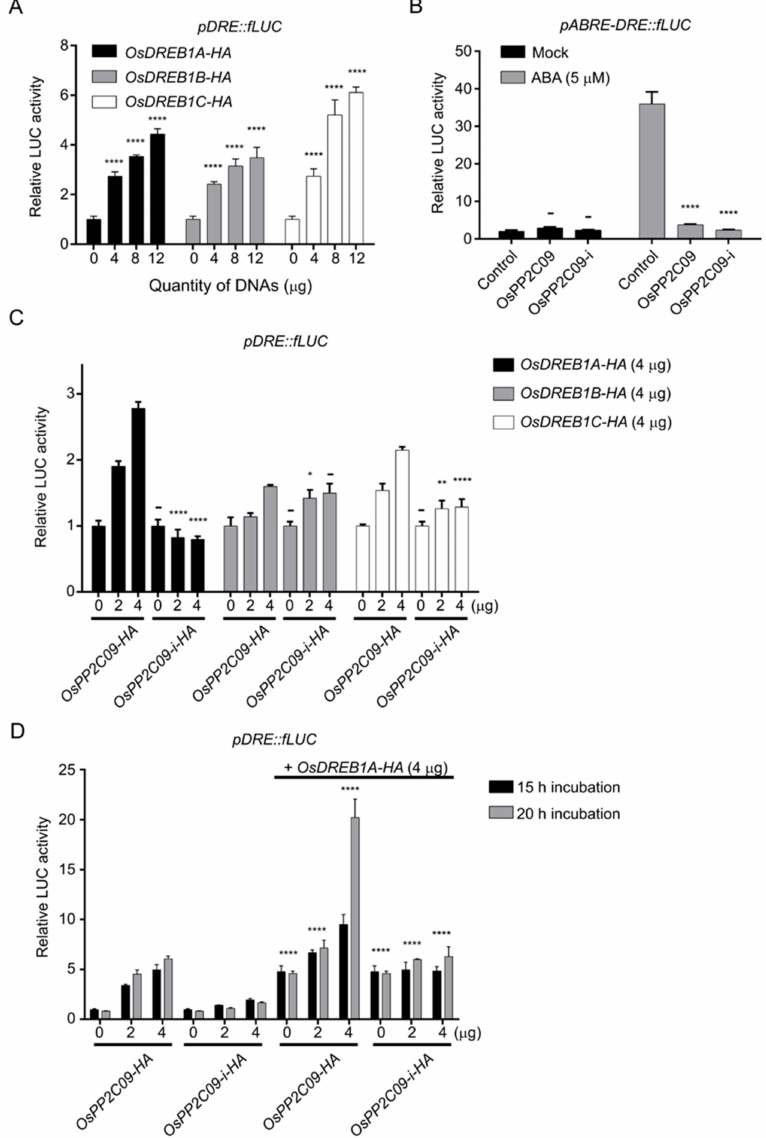
Figure 8. Activation of pDRE::fLUC by overexpression of OsDREB1s. ( A ), Activation of pDRE::fLUC depends on OsDREB1s effector plasmid DNA amounts. One-way ANOVAs were performed with comparing to 0 µ g of effector DNAs. ( B ), Confirmation of the lack of activation of the pABRE- DRE::fLUC reporter by OsPP2C09-i. One-way ANOVAs were performed, comparing to the control. ( C ), Effects of OsDREB1-mediated activation by OsPP2C09 or OsPP2C09-i. Two-way ANOVAs were performed with comparing to WT (OsPP2C09). ( D ), Effects of OsPP2C09 on the activity of OsDREB1A at two time points. Two-way ANOVA was performed, comparing to non-OsDREB1A. The indicated effector and marker DNAs were introduced into rice protoplasts by the PEG-mediated transfection method and then incubated for 15 h or 20 h. Induced LUC activity was detected with a dual-luciferase reporter assay system. All values of panels are means ± SD ( n = 3). ****: p < 0.0001, **: p < 0.01, *: p < 0.05, -: not